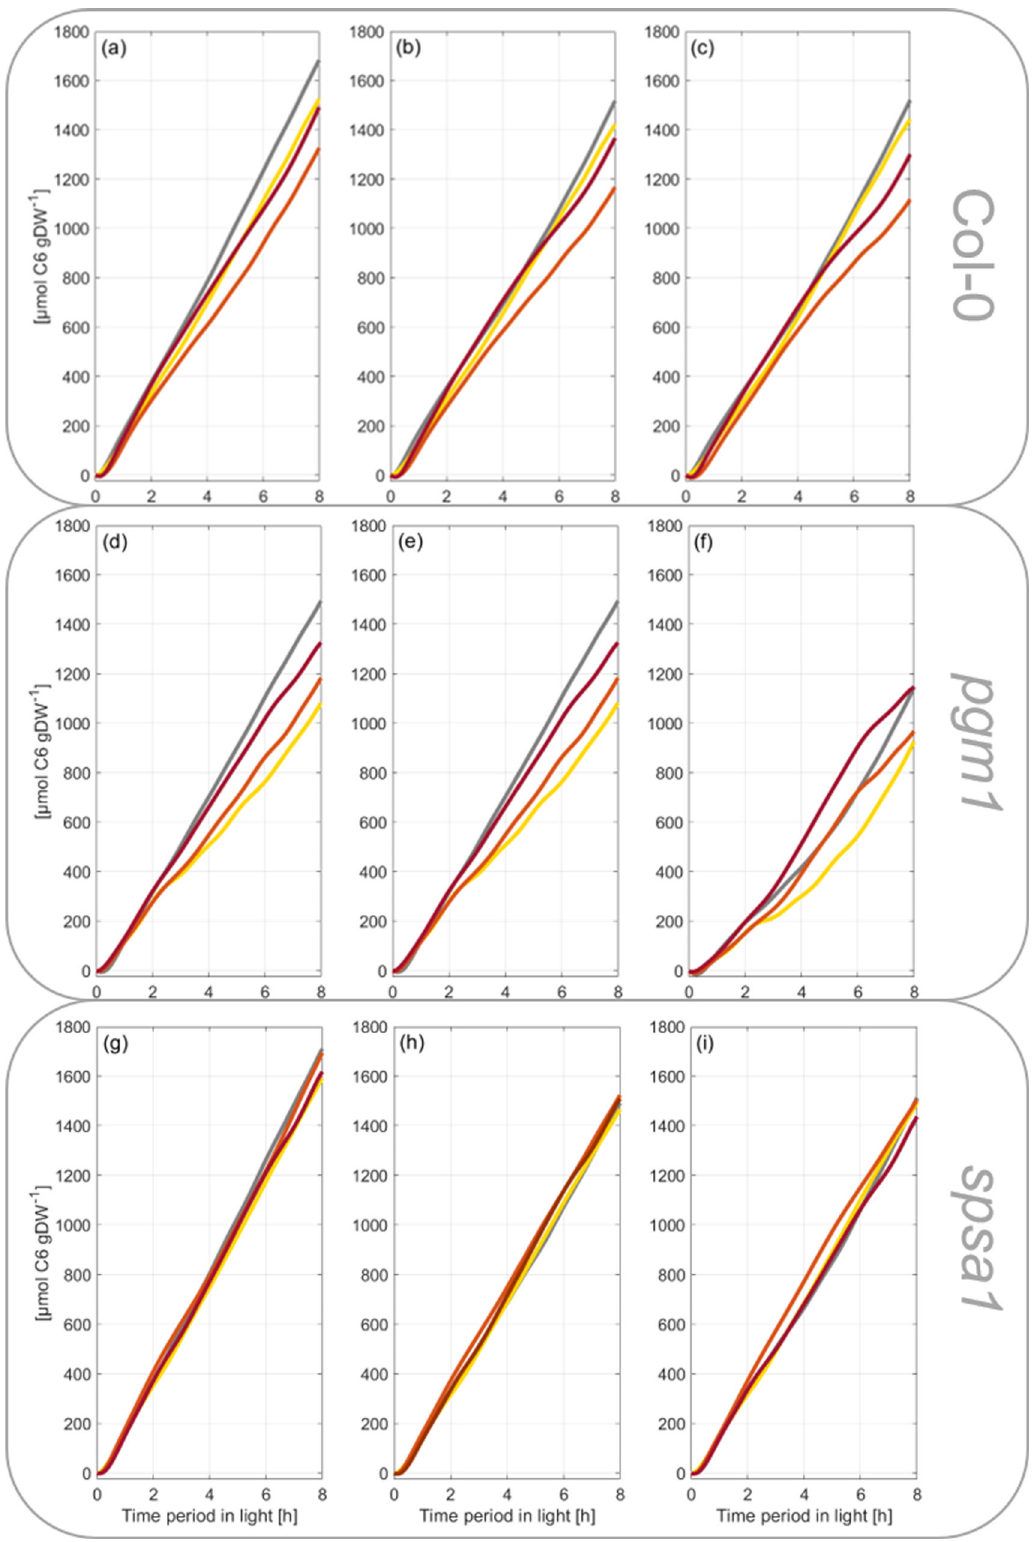
Fig. 9 Integrals of carbon balance rates during transient heat exposure. NPS rates and rates derived from BE 1 and BE 2 were integrated over time to reveal the total sum of net carbon gain during the light period. a – c Col-0 integrals of NPS rates ( a ), BE 1 ( b ), and BE 2 ( c ). d – f pgm1 integrals of NPS rates ( d ), BE 1 ( e ), and BE 2 ( f ). g – i spsa1 integrals of NPS rates ( g ), BE 1 ( h ), and BE 2 ( i ). Numerical values of integrals are provided in the supplements (Supplementary Data